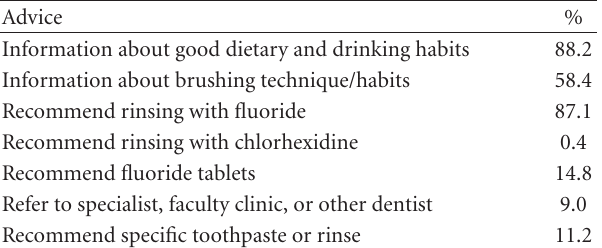
Table 1: The frequency (%) of dentists’ general patient advice(s) in the patient case. n : number of dentists responding to each